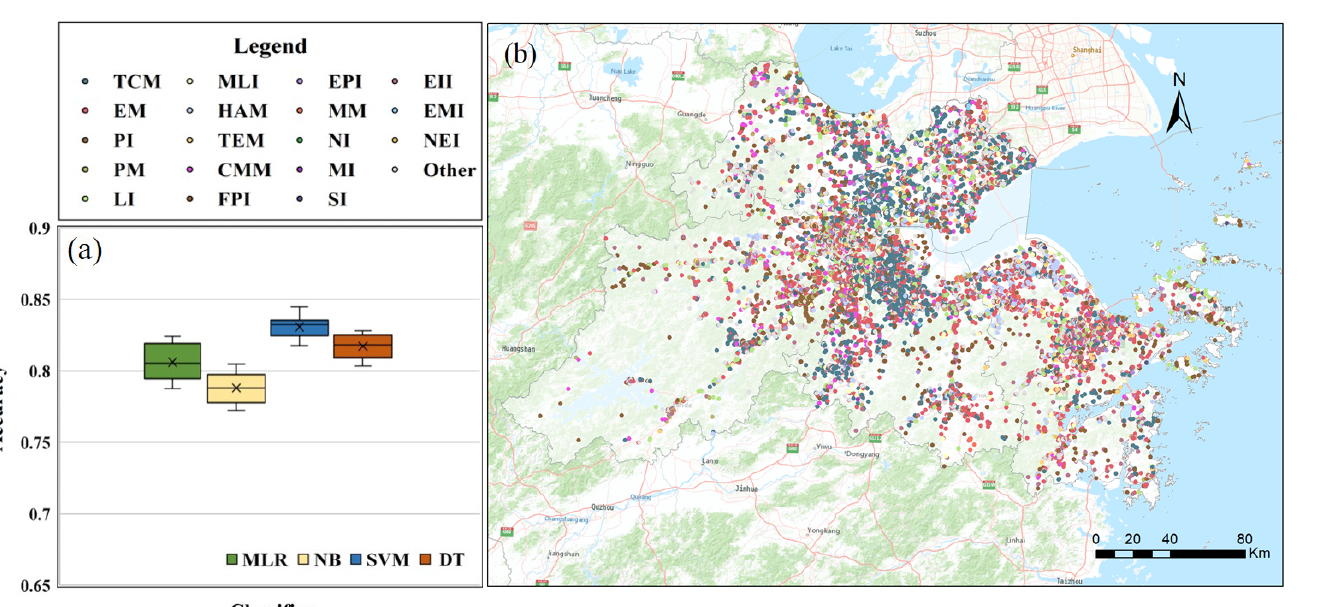
Figure 6. Industrial structure classification results based on industrial POIs: ( a ) accuracies of four models, ( b ) intra-structure classification result of UAHB. models, ( b ) intra-structure classification result of